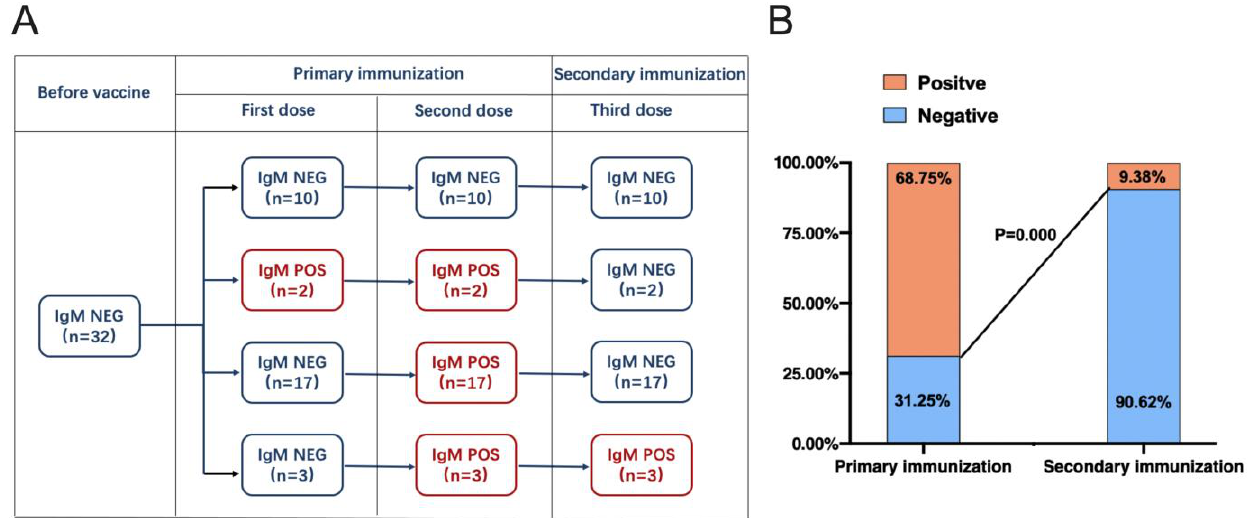
Figure 2. Positive conversion of IgM in primary immunization and secondary immunization. ( A ) Longitudinal positive conversion of anti-SARS-CoV-2 IgM antibodies. ( B ) Positive conversion rates of anti-SARS-CoV-2 IgM antibodies in primary immunization and secondary immunization. The McNemar test was used to compare paired positive conversion between primary immunization and secondary immunization. Abbreviations: NEG: negative, POS: positive.